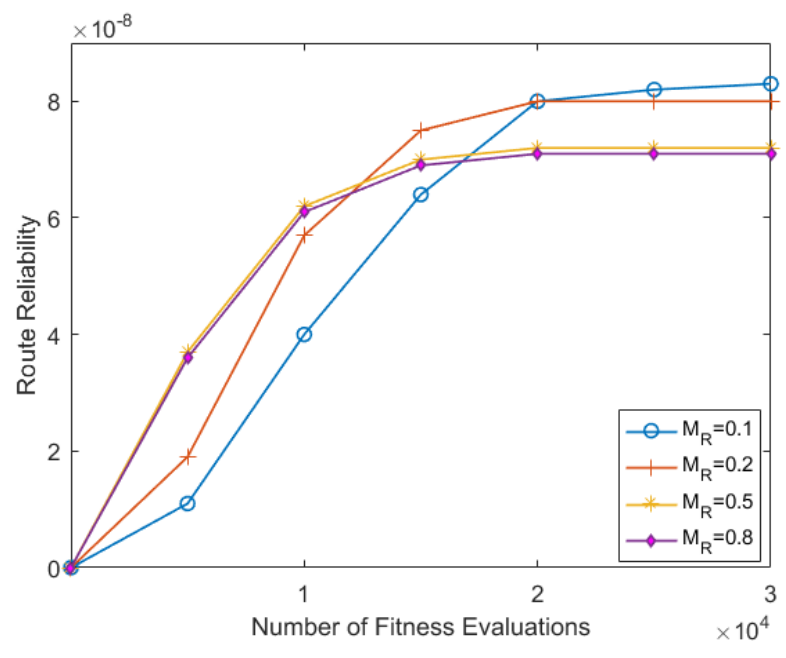
Figure 4. Mating probability Rate M R —over 1000 Monte Carlo